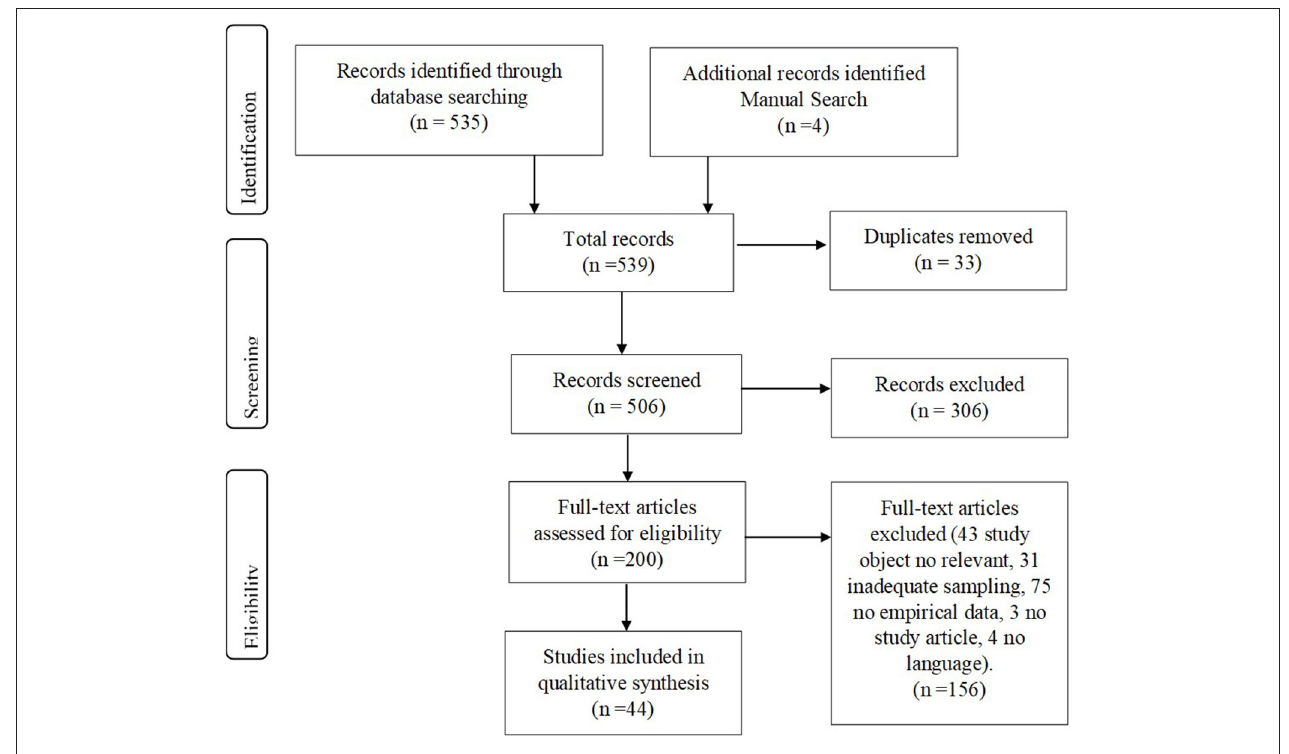
FIGURE 1 | Flow chart for the article selection